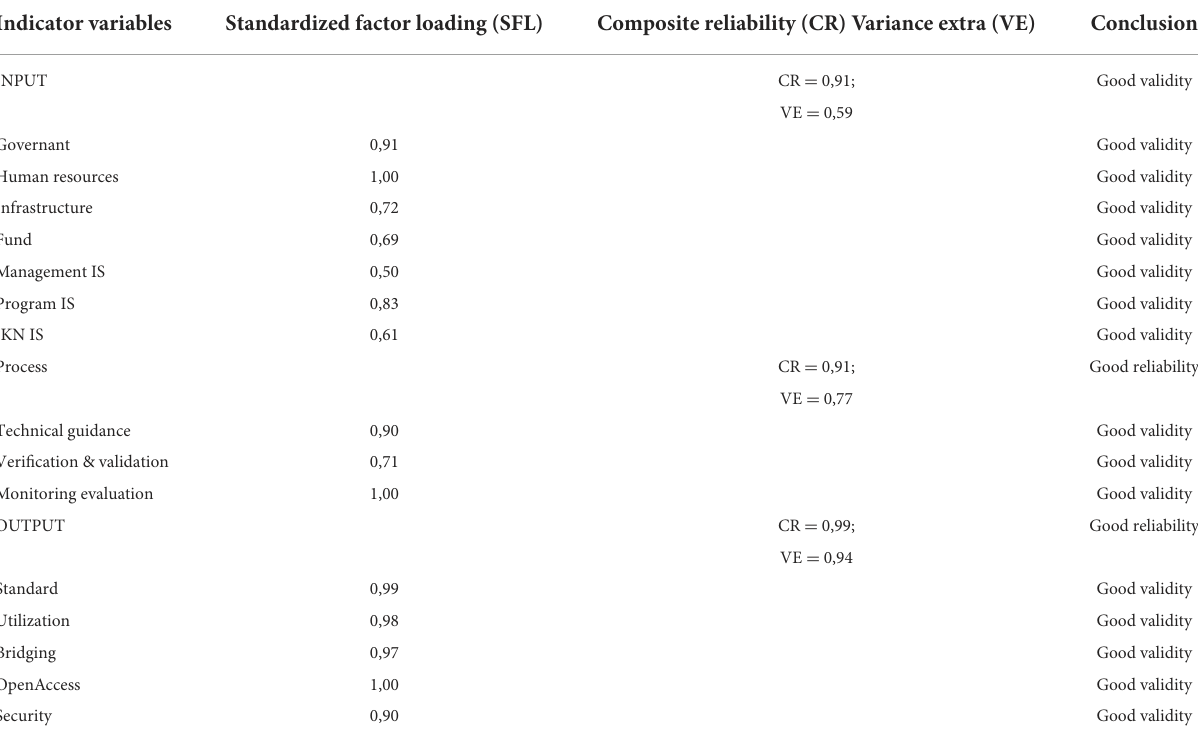
TABLE 1 Results of measurement model